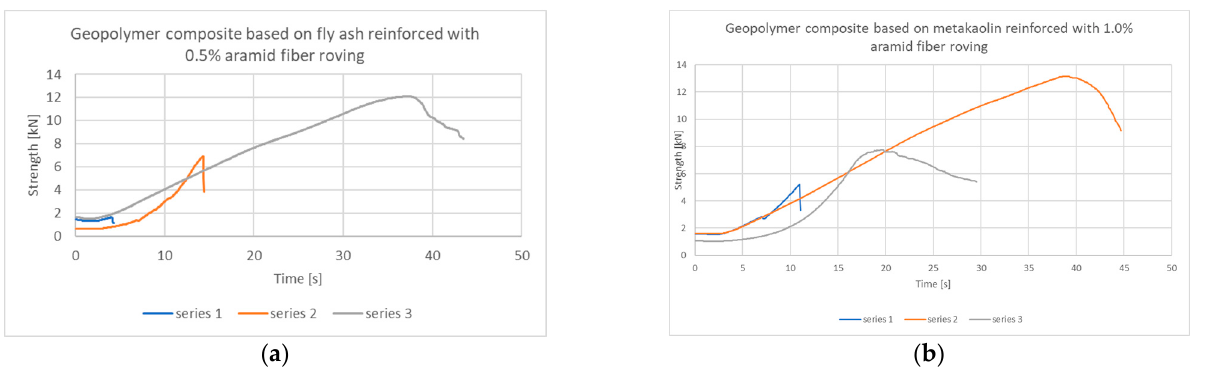
Figure 8. Strength–time composite behavior for a geopolymer matrix based on: ( a ) fly ash with 0.5% aramid fiber roving; ( b ) metakaolin from 1.0% aramid fiber roving, in subsequent series of repetitions.